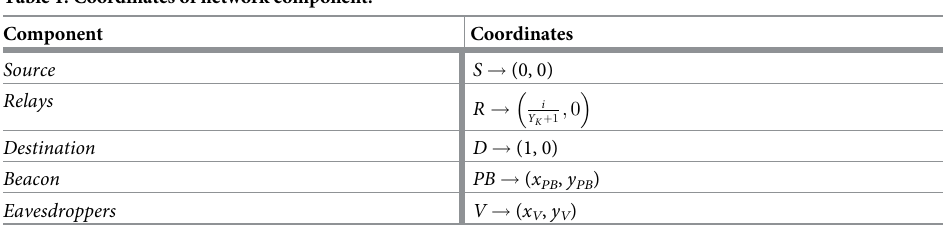
Table 1. Coordinates of network component.